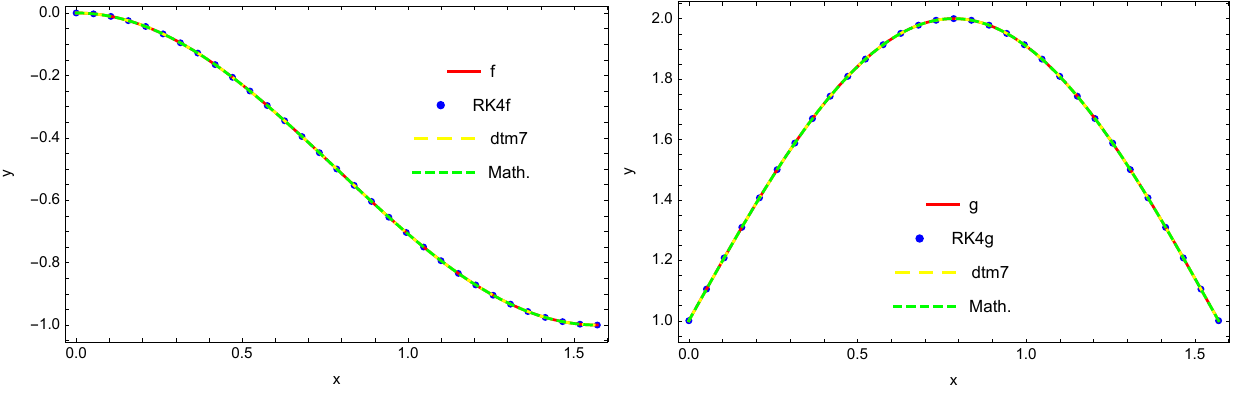
Figure 4. Exact solution and the approximate solutions.